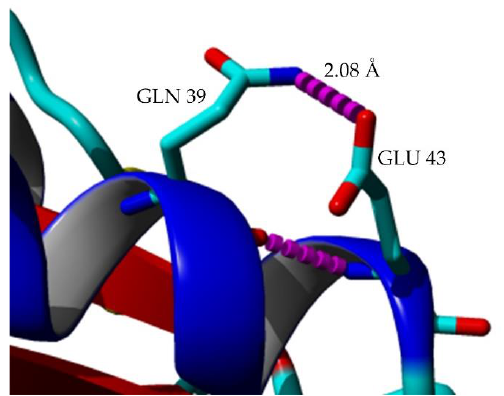
Figure 7. Hydrogen bond between residue Glu43 and Gln39 presented in homology model of D43E mutant structure. Hydrogen bond colored in magenta. The figure was generated using YASARA software [20]. Table 4. Number of molecular interactions in single mutant modeled structures calculated using module available in YASARA software [20].